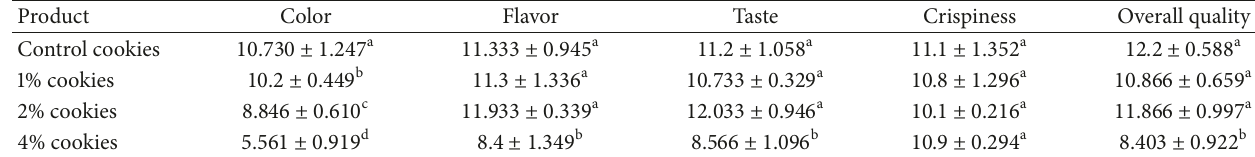
Table 2: Sensory evaluation of cookies with added 𝛽 -glucan compared to the control cookies.